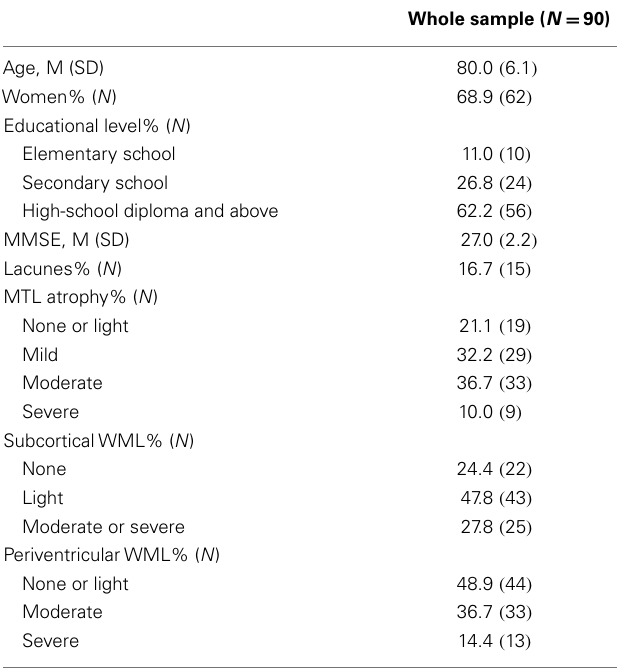
Table 1 | General characteristics in the whole sample